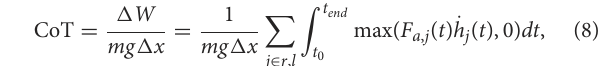
FIGURE7 Time evolution of energies for the inputs ω v (green), and total (red) energies. The shaded areas denote the right single stance phase (pink), left single stance phase (sky blue), DS phase (purple), and F